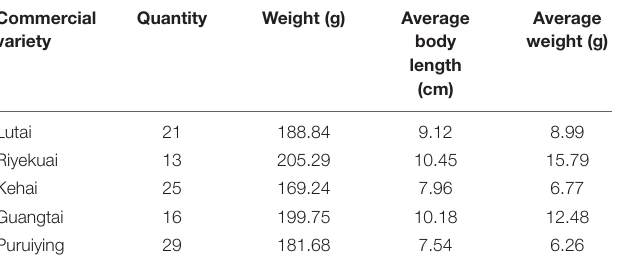
TABLE 2 | Samples for five commercial varieties of L. vannamei .